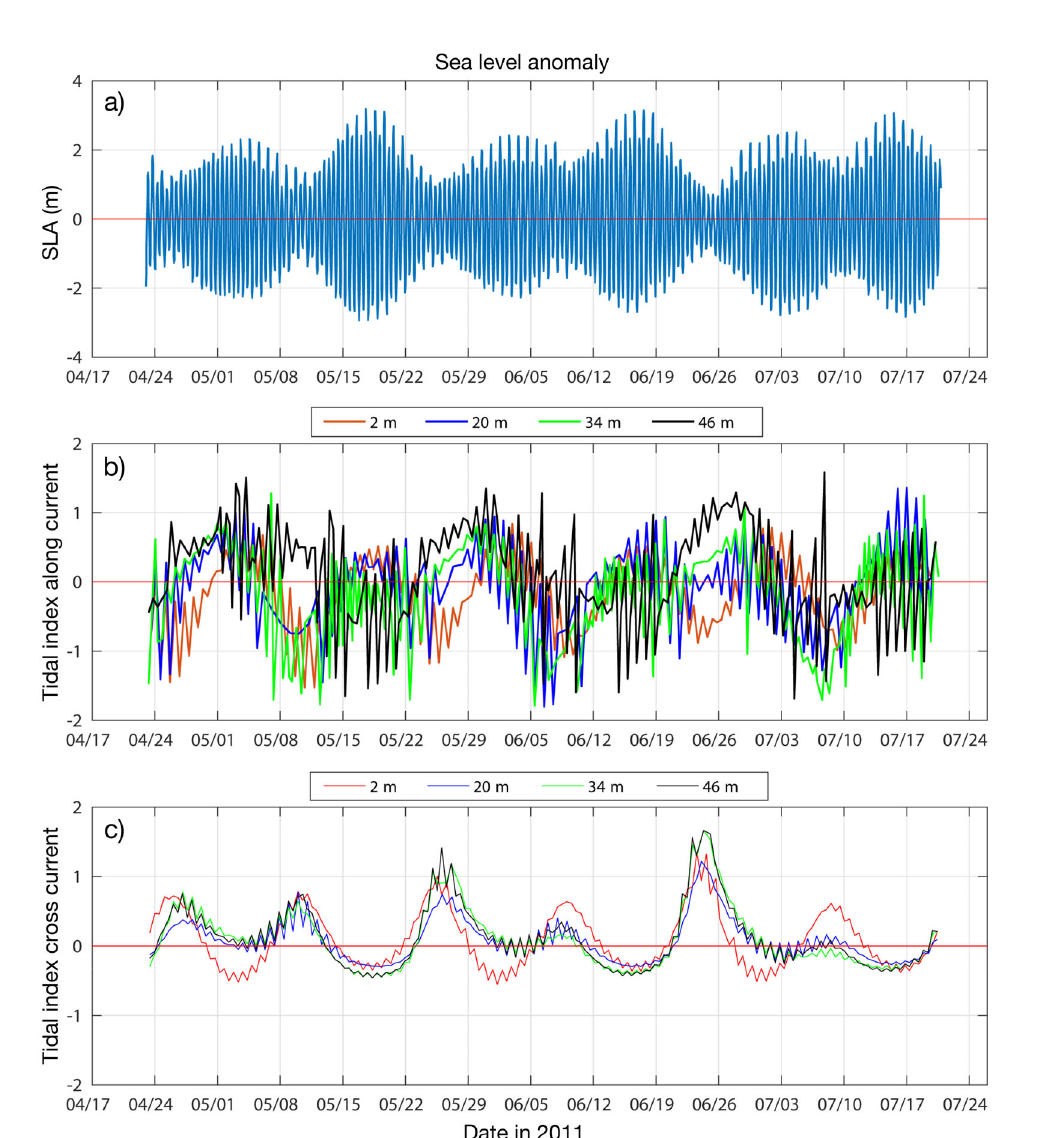
Fig. 11. (a) Sea level anomaly (SLA, in m). (b) Tidal asymmetry index (AI DV ) calculated using along-channel currents. (c) AI DV calculated using cross-channel currents. This index (dimensionless) was calculated using currents measured at 2, 20, 34 and 46 m depth. Caucahue Channel, 17 April to 24 July